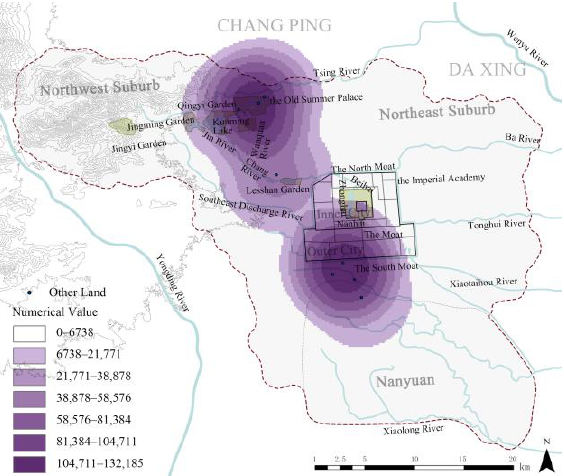
Figure 14. Spatial distribution and density analysis map of other land.